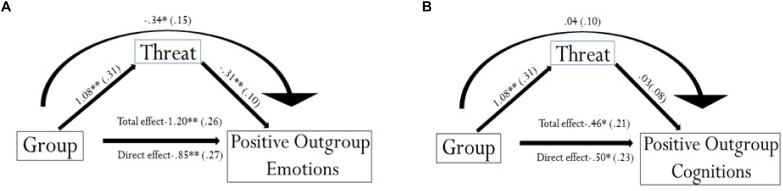
(A) Shows the Mediation model with Group, Perceived Threat and Emotions Outgroup. The predictor variable Group was coded 1 for right and 2 for left-wing participants. This means that an increase of 1 political orientation – namely, being left-wing – indicates a decrease in positive emotions toward the outgroup (and thus an increase in negative ones). The direct path remained significant after inserting Perceived Threat, but the effect size decreased from –1.20 to –0.85, p < 0.01. The indirect effect of X on Y mediated by M was significantly different from 0 (B = –0.34, Boot Se.1592, BootLLCI –0.7030, BootULCI –0.1056, p = 0.02). (B) Shows Mediation model with Group, Perceived Threat and Cognition Outgroup. The predictor variable Group was coded 1 for right and 2 for left-wing participants. Thus, an increase of 1 political orientation – namely, being left-wing – indicates a decrease in positive traits assigned to the outgroup (and an increase of negative ones). The path from the mediator to the dependent variable was not significant p > 0.05. The direct path was significant, but the indirect path was not (B = 0.0414, Boot SE.1097, BootLLCI –0.1831, BootULCI.2573). ∗p < 0.05; ∗∗p < 0.01.